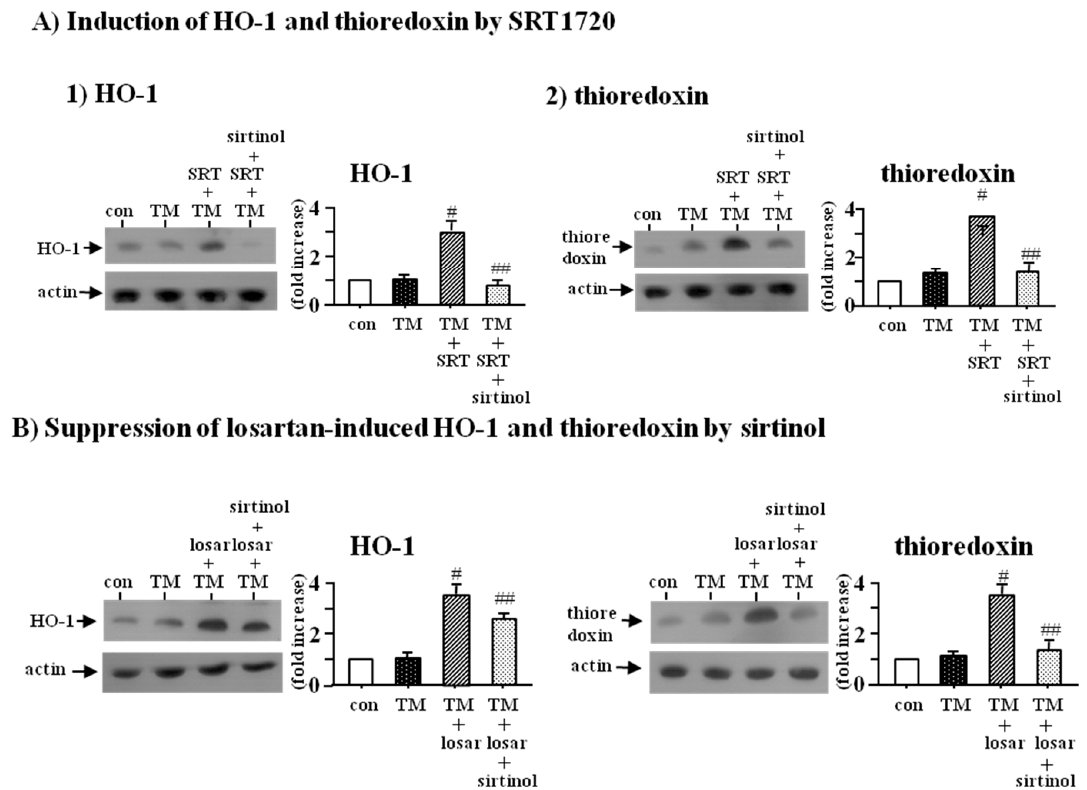
Figure 4. Induction of HO-1 and thioredoxin by SRT1720 ( A ) and suppression of losartan-induced HO-1 and thioredoxin by sirtinol ( B ). Proximal tubular cells were incubated with tunicamycin (TM, 0.2 µM) with or without SRT1720 (SRT, SIRT1 inducer, 2.5 µM) and sirtinol (SIRT1 inhibitor, 10 µM) for 24 h ( A ); Proximal tubular cells were incubated with tunicamycin (TM, 0.2 µM) with or without losartan (losar, 10 µM) and sirtinol (SIRT1 inhibitor, 10 µM) for 24 h ( B ). Expression of heme oxygenase-1 (HO-1) and thioredoxin was examined by Western blot analysis. The relative densities of the bands for HO-1 and thioredoxin were normalized to those for actin for standardization. Representative blots and quantitative analysis from three independent experiments were shown. Results were expressed as n -fold increase over control as mean ± S.E. #: p < 0.05 vs. con (control) or TM; ##: p < 0.05 vs. TM + SRT or TM + losar.